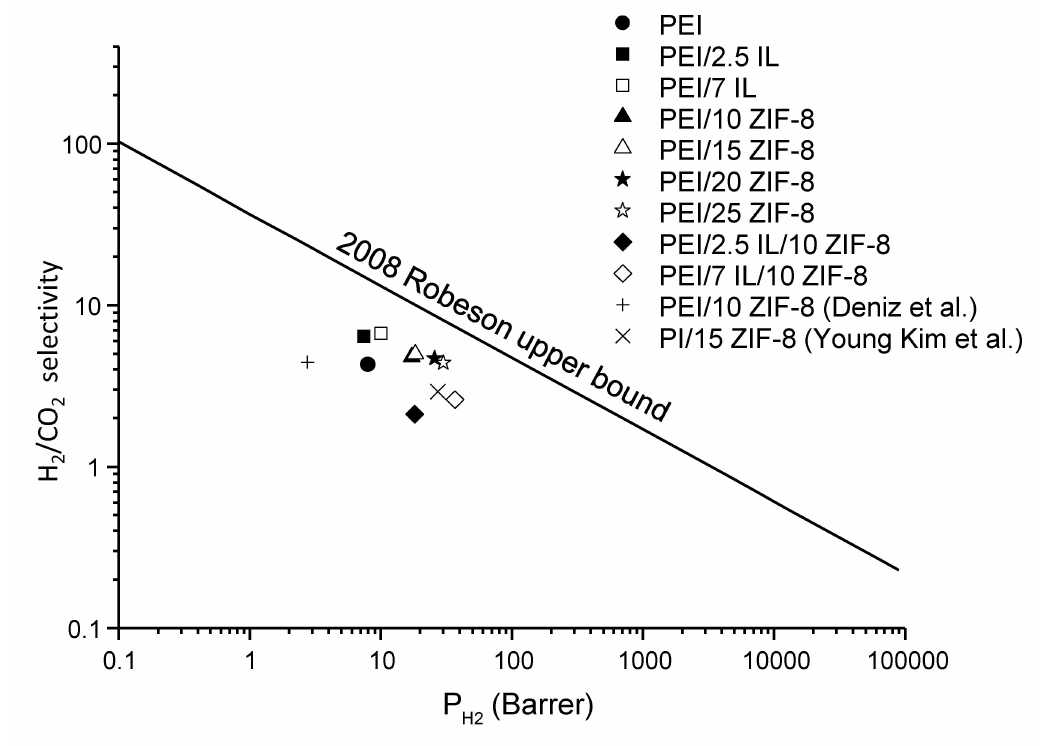
Figure 13. H 2 /CO 2 selectivity of the prepared membranes versus H 2 permeability, compared to literature data